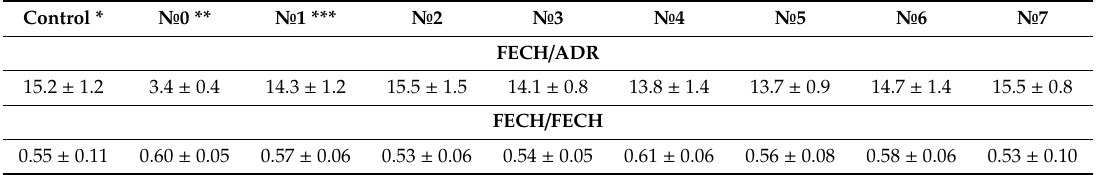
Table 2. K d values ( µ M) of FECH / ADR and FECH / FECH complex formation in the presence of 100 µ M isatin